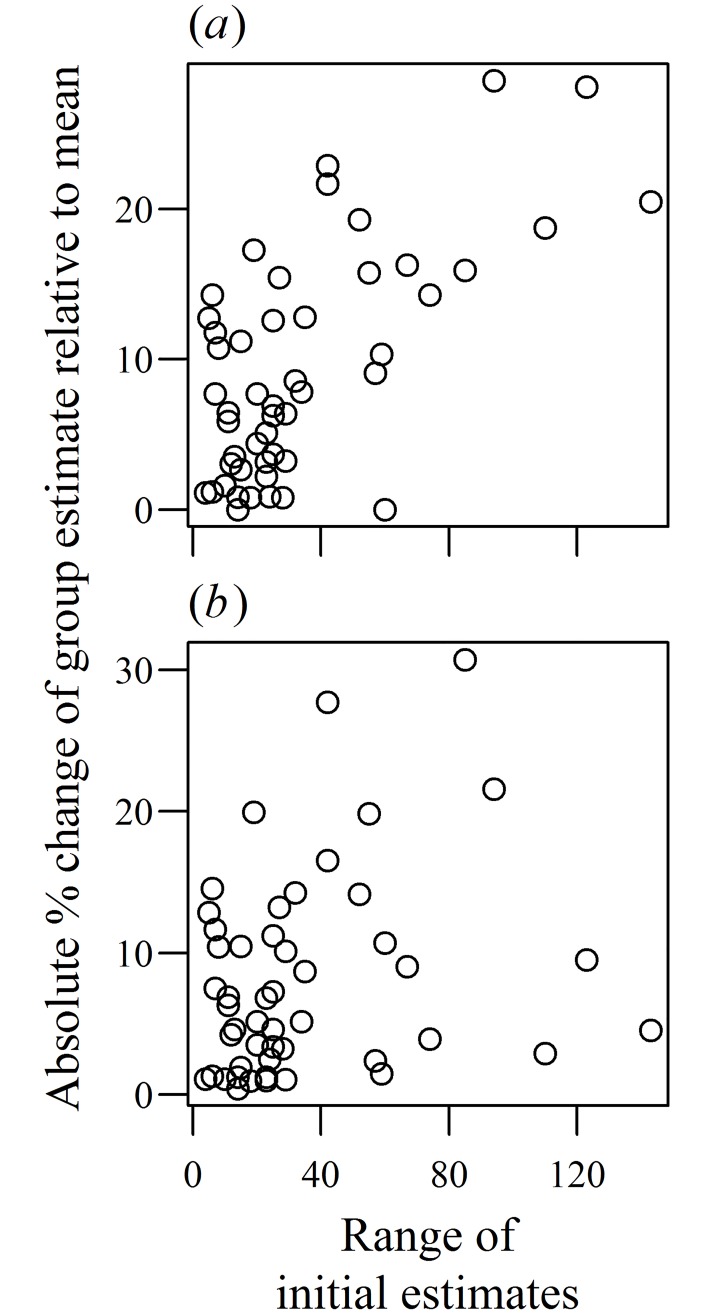
How initial disagreement shifts the consensus group estimates away from the mean of initial estimates in Experiment 1.Disagreement is the range of initial estimates. (a) shows the absolute percentage difference relative to the arithmetic mean, and (b) relative to the geometric mean.